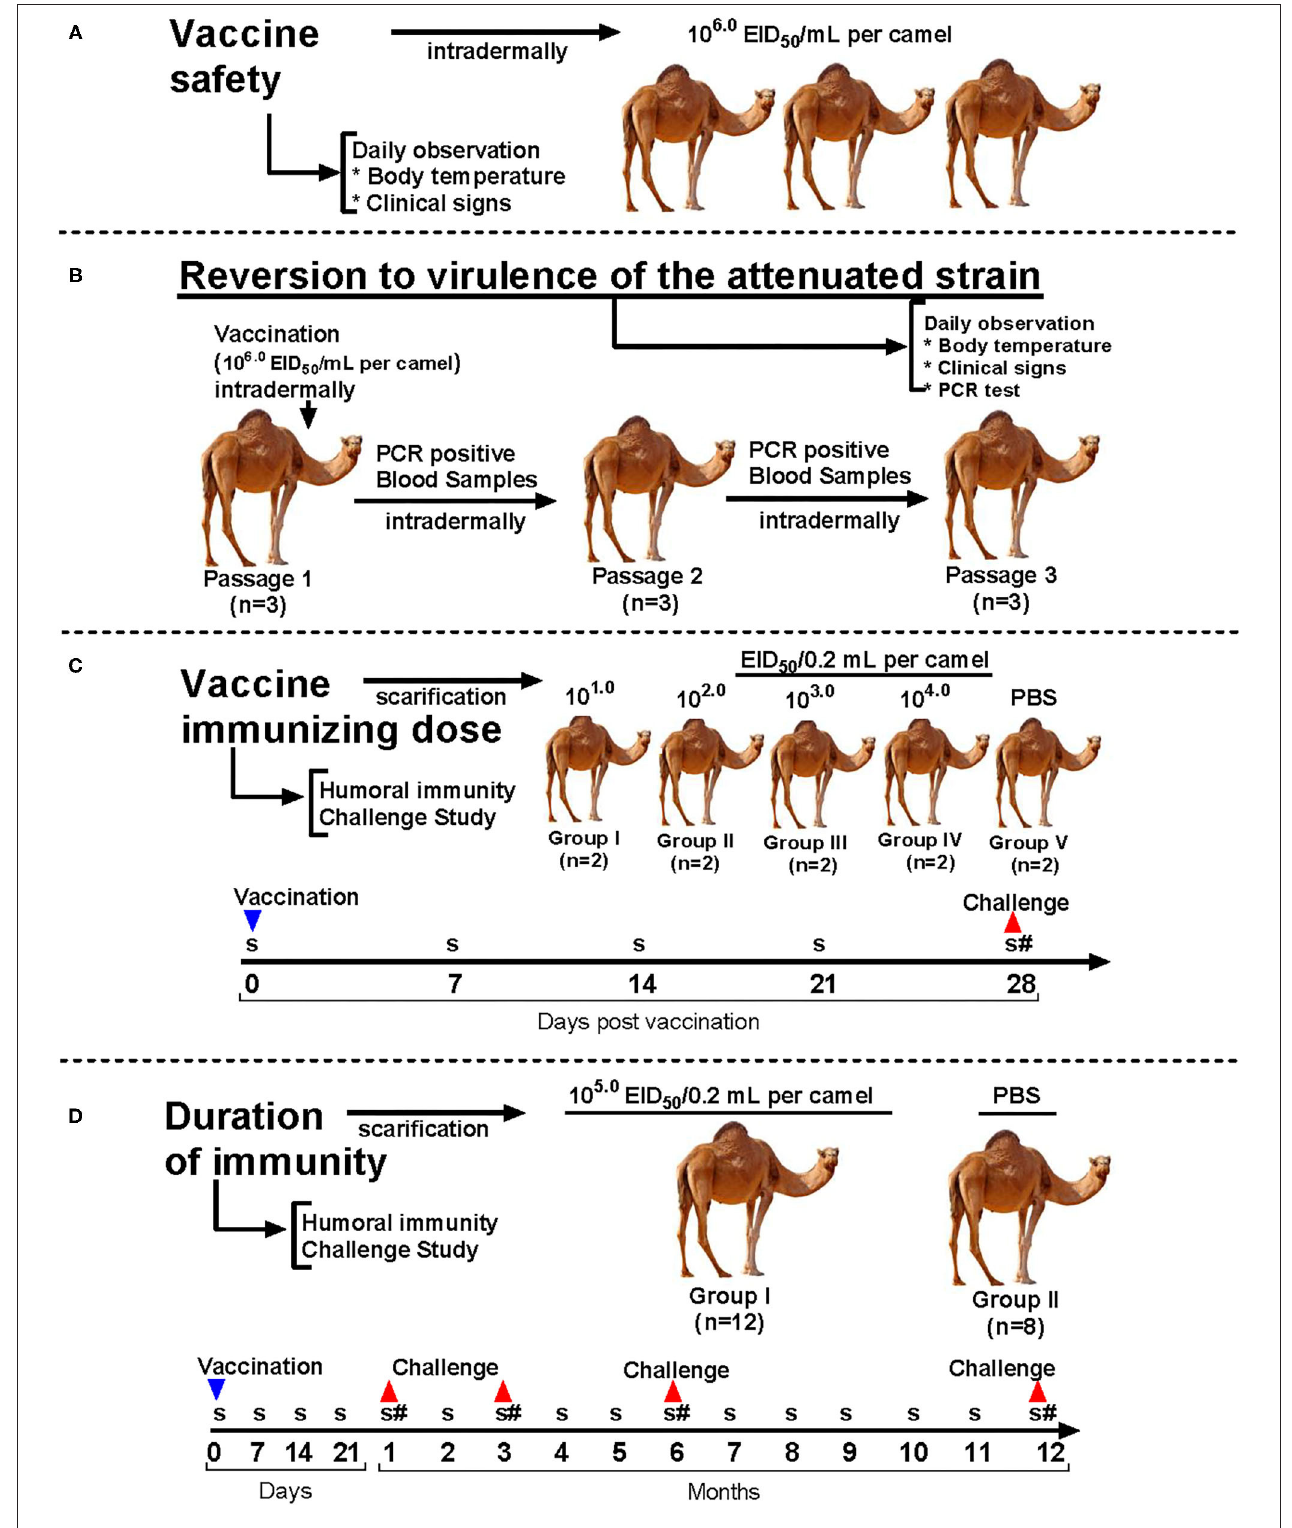
FIGURE 1 | Experimental design of the study. (A) Vaccine safety evaluation; (B) Reversion to virulence evaluation; (C) Vaccine immunizing dose and protectiveness evaluation; (D) Duration of the immune response and protective efficacy evaluation. S , serum collection; # , challenge.